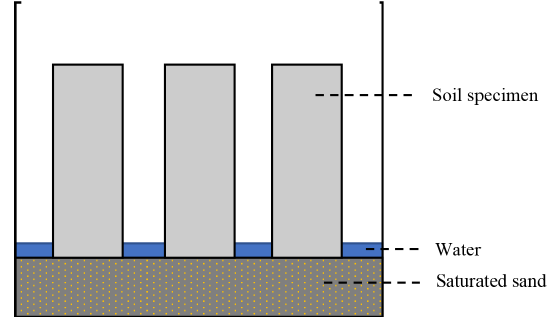
Figure 1. Soil specimens with latex coating, situated on saturated silica during for the primary wetting